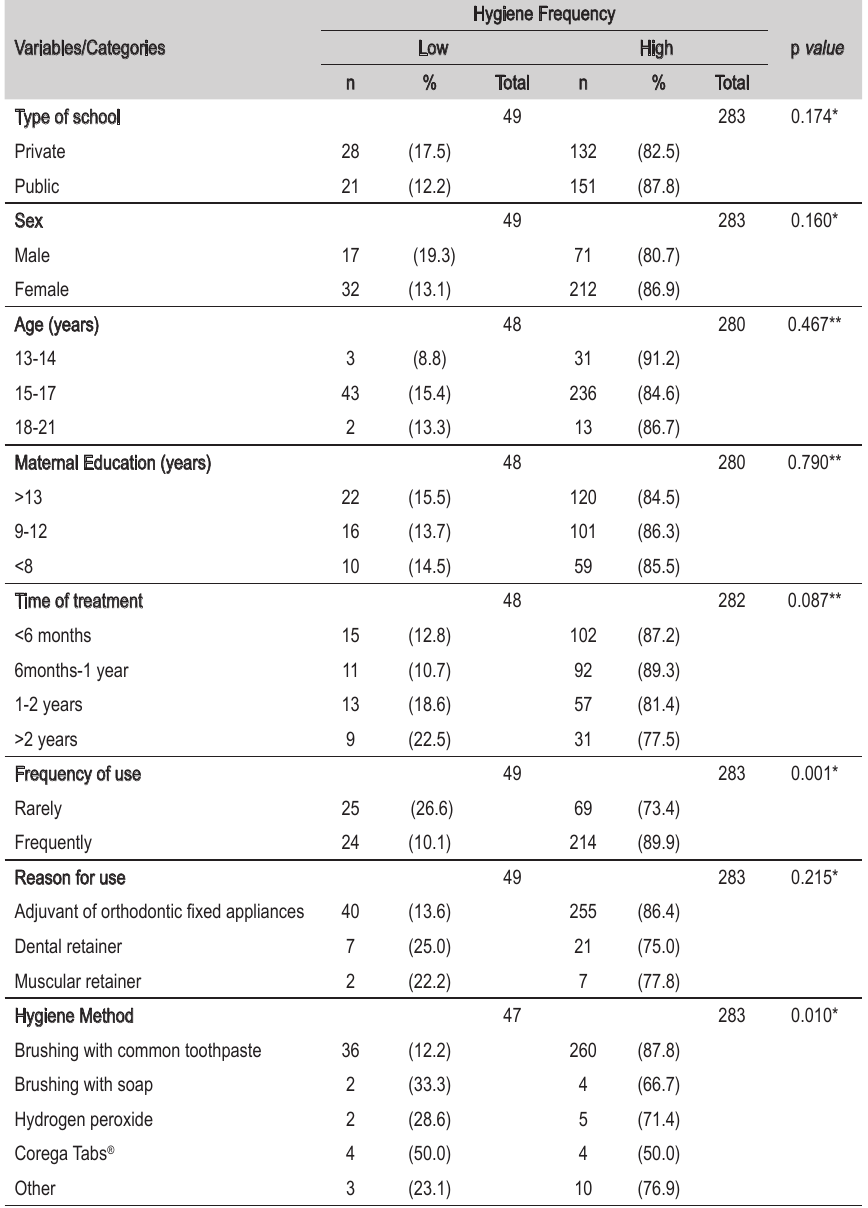
Table 3 - Bivariate analysis of hygiene frequency of removable appliances wore by the students according to socio-demographic and behavioral characteristics of students. Pelotas, Brazil